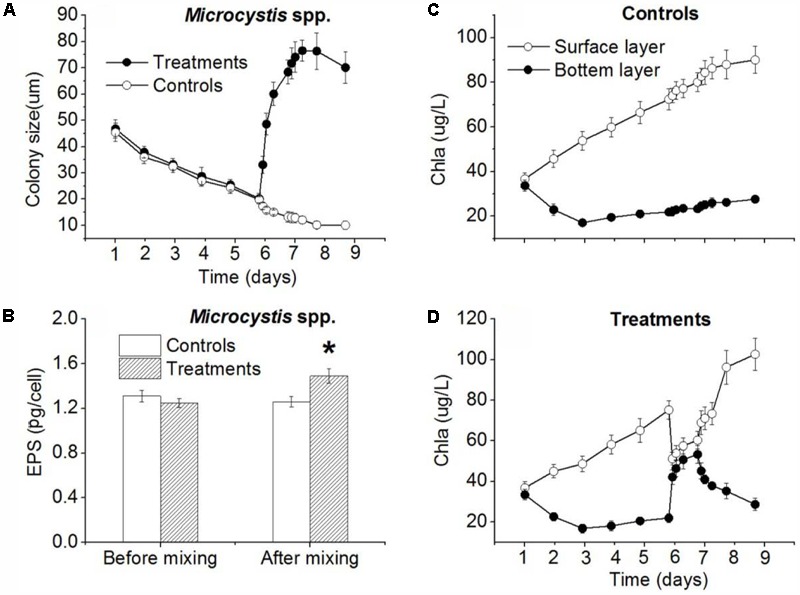
Simulation of mixing effect on Microcystis spp. colony size, EPS concentration and vertical distribution of Chl a in plastic barrels in TLLER. (A) Colony size in control and treatment (including 24-h disturbance during experiment) change with time. (B) EPS concentration in control and treatment (including 24-h disturbance during experiment) change with time. (C) Surface and bottom Chl a concentration in control change with time. (D) Surface and bottom Chl a concentration in treatment (including 24-h disturbance during experiment) change with time; error bars was indicated by ±SD (∗p < 0.05, ∗∗p < 0.01, n = 3).